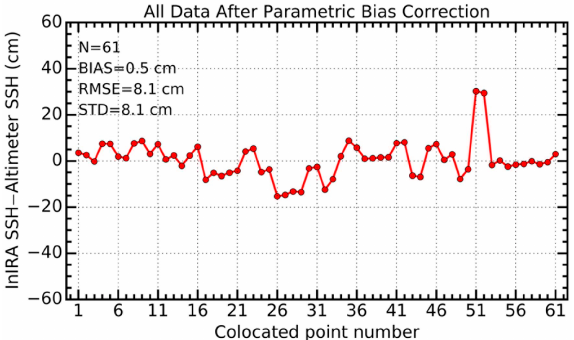
Figure 9. SSH di ff erence statistics between the Interferometric Imaging Radar Altimeter (InIRA) Figure 9. SSH difference statistics between the Interferometric Imaging Radar Altimeter (InIRA) and traditional altimeter after further parametric bias correction.